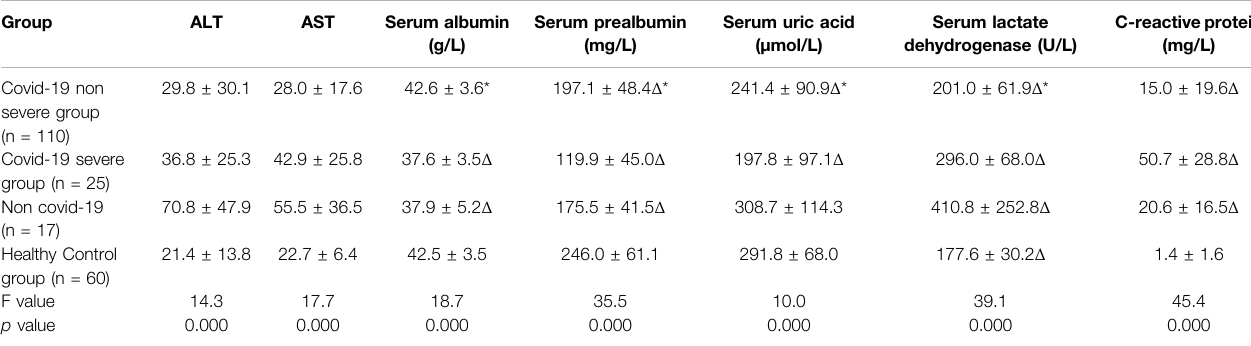
TABLE 2 | Comparison_of_four_groups_of_detection_index_level. Group ALT